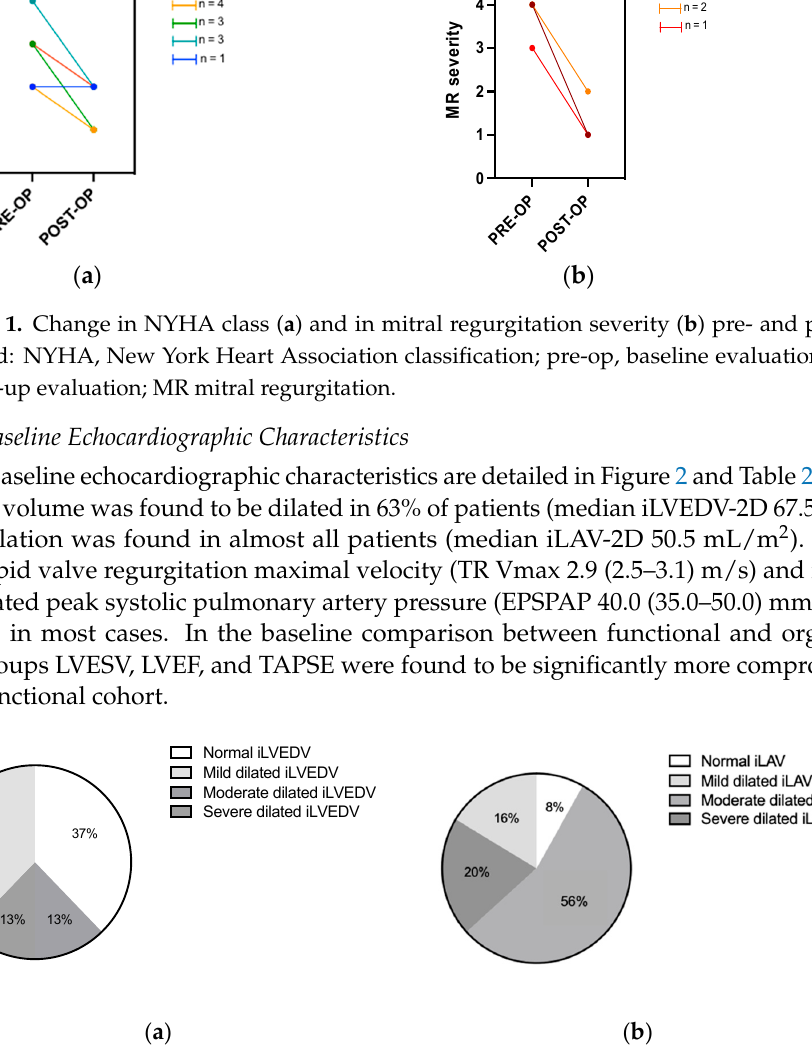
Figure 2. Grading of severity of left ventricular ( a ) and left atrial dilatation ( b ). Legend: iLVEDV, indexed left ventricular end-diastolic volume; iLAV, indexed left atrial volume. Table 2. Baseline echocardiographic characteristics.